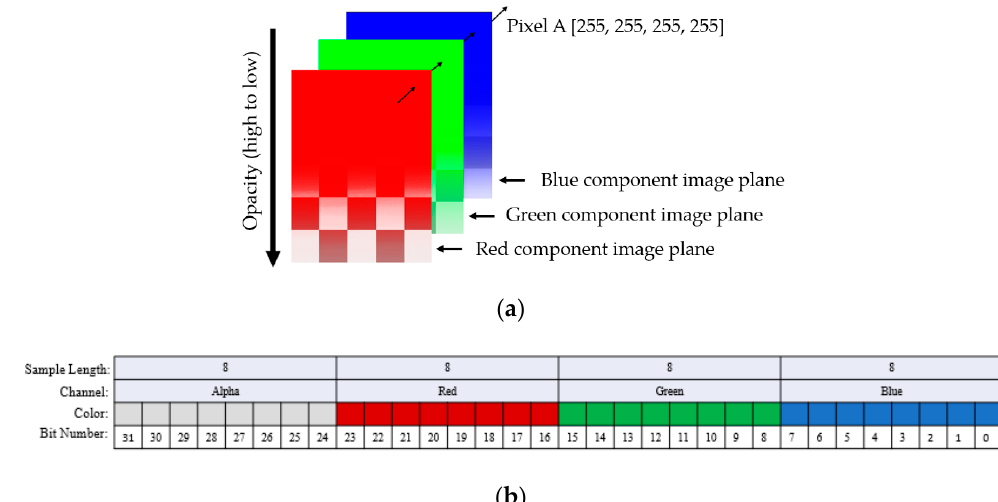
Figure 5. Representation of an image obtained using a Samsung Galaxy S7 smartphone. ( a ) Alpha- Red-Green-Blue (ARGB) representation of an image. An ARGB image consists of four planes, which are the alpha, red, green, and blue channels. Each channel’s intensity value can vary from 0 to 255. A pixel in the original image shows the combination of the intensity values of the color channels, and ( b ) the 32-bit representation of a pixel of the image ( a ). In an ARGB image, each pixel corresponds to a specific 32-bit binary value, of which the lowest eight bits represent blue, the next 8 bits represent green, the next eight bits for red, and the highest eight bits represent the alpha channel intensity values. The pixel’s color is the combination of these color intensities.